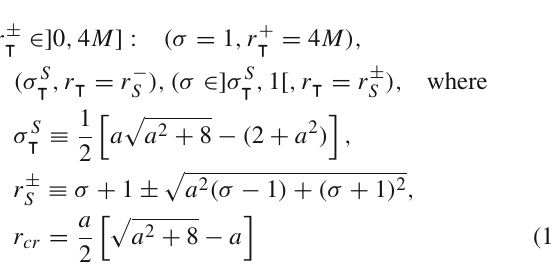
Fig. 10 Inversion spheres in double tori systems.Tori effective poten- tial for different spins and fluid specific angular momentum as signed on the panels. The tori centers and cusps are also signed with verti- cal lines. It is clear the presence of an orbiting double tori systems. Tori configurations and the inversion points r ± (cid:2) are shown in the plane ( y / M , z / M ) where σ = sin 2 θ = y 2 /( z 2 + y 2 ) and r = for different fluid specific angular momenta (cid:6) . (The most general solu-